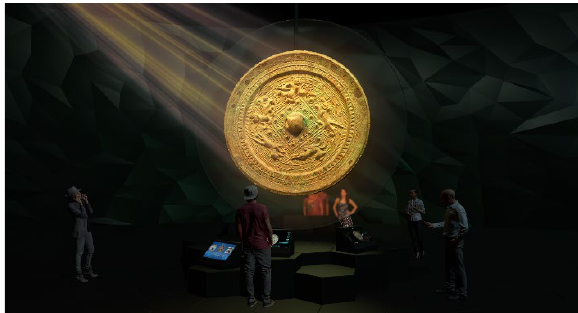
Figure 4. Space design of scientific exhibition system for the bronze